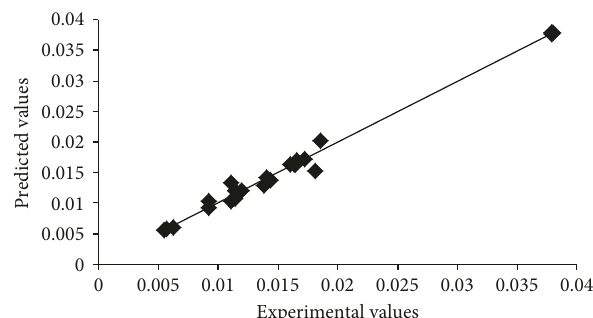
Figure 4: Correlation between the predicted and experimental C / C 0 values for PN simulated using